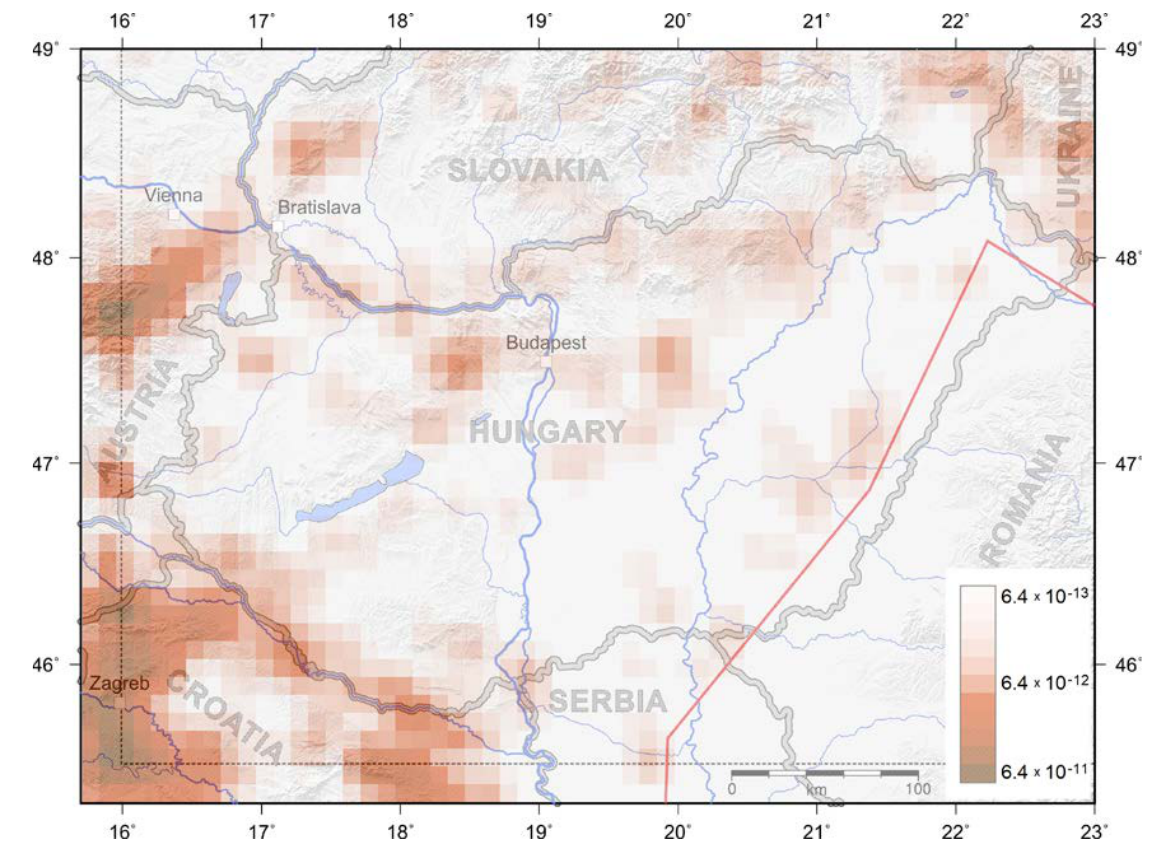
Figure 4. Modelled background density µ · u ( x , y ) plotted at 10 km pixel size (unit is 1/ ( day · km 2 ) ).